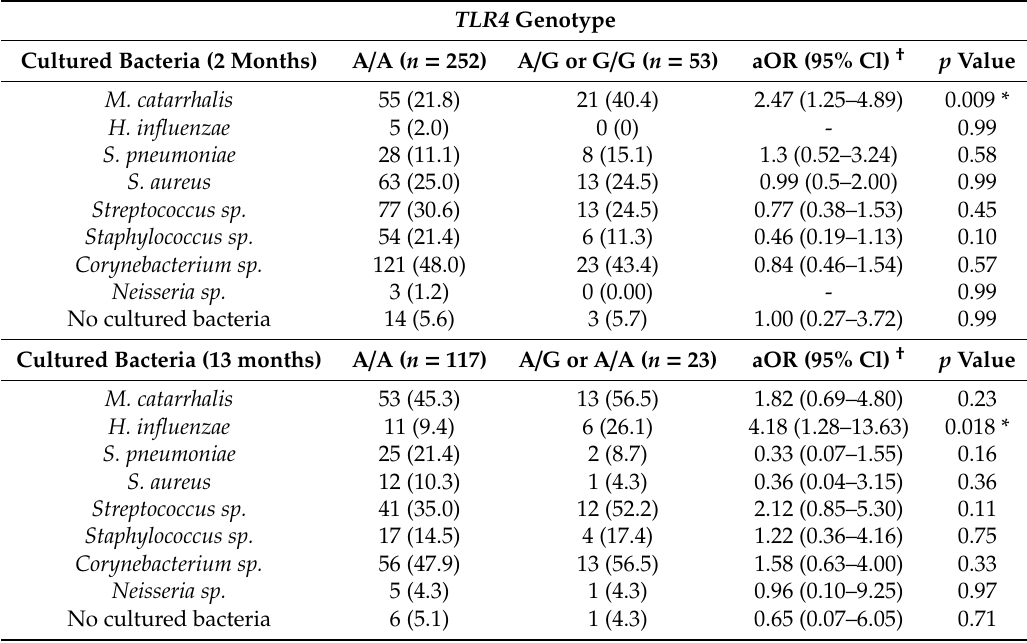
Table 2. Association between TLR4 gene polymorphism Asp299Gly (rs4986790) and nasopharyngeal bacterial colonization rates at 2 months and 13 months of age.